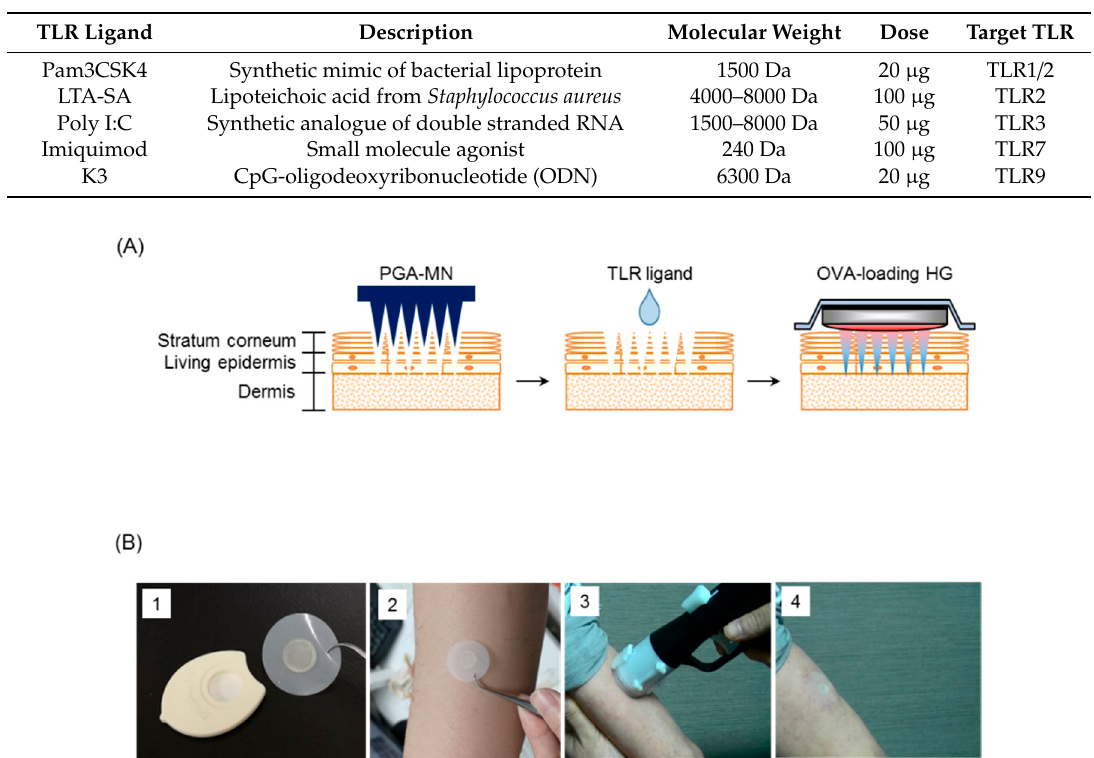
Table 1. Types and description of TLR ligands using transcutaneous administration.